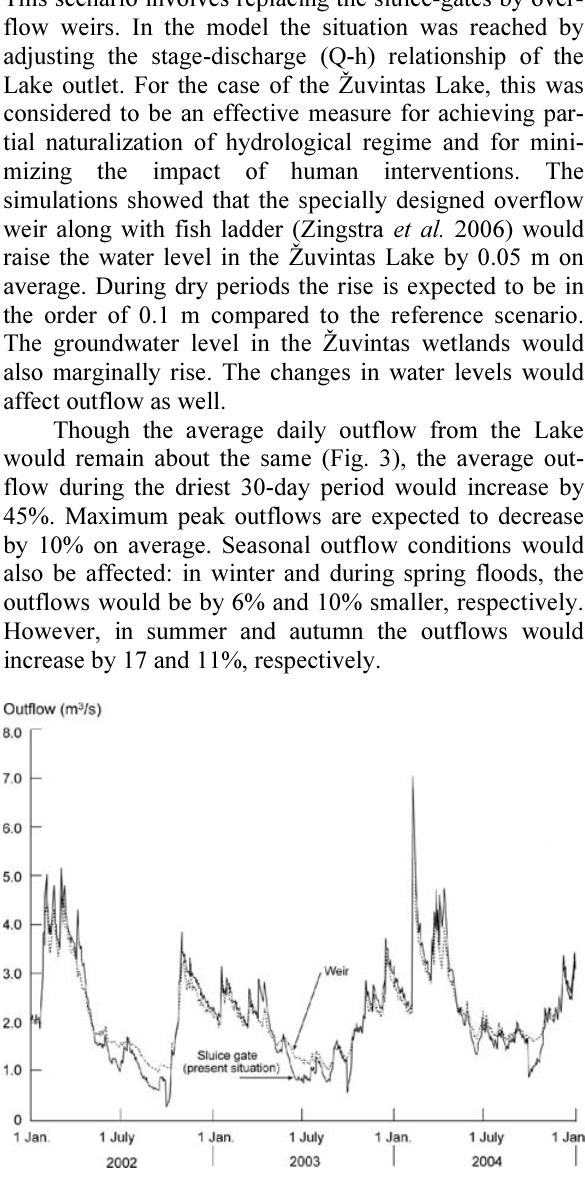
Fig. 3. Impact of the replacement of sluice-gates by weir on the outflow conditions from the Žuvintas